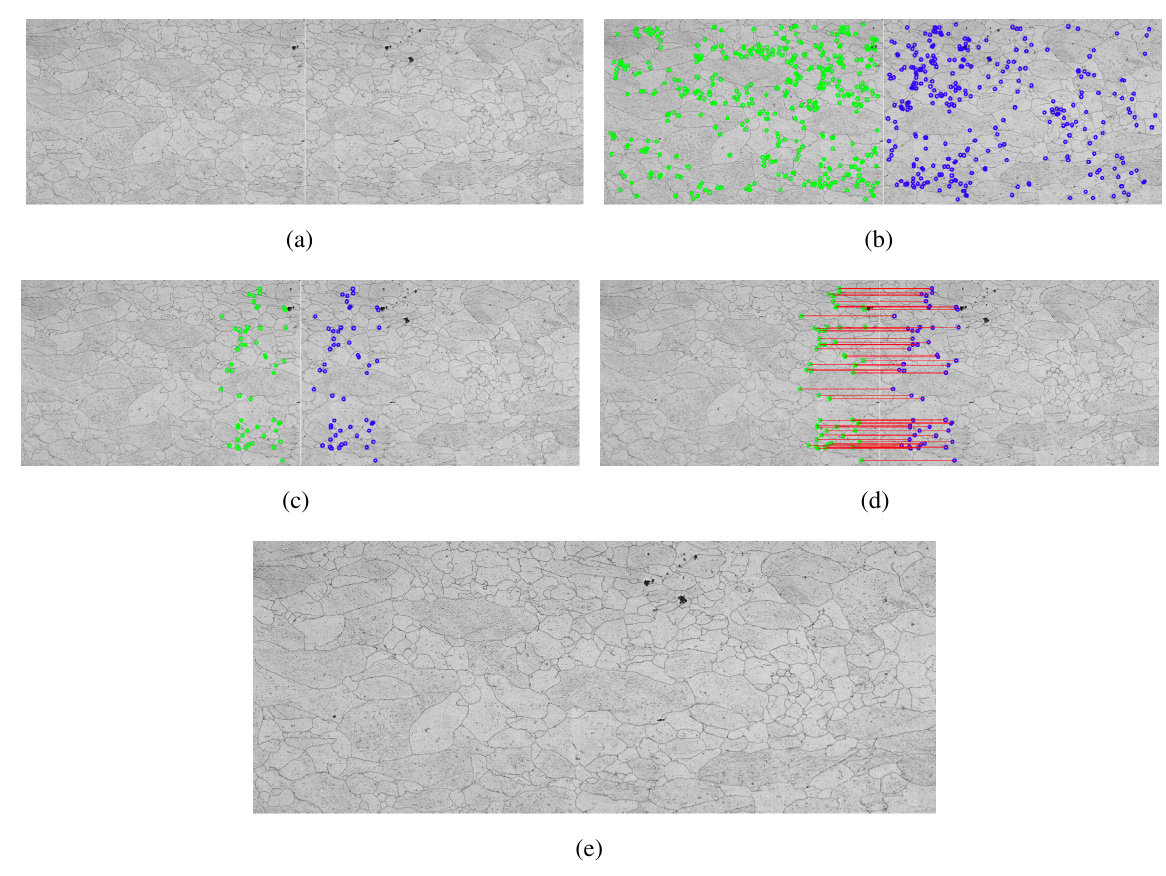
Figure 5. Example of the step by step construction using Transformed SURF, ( a ) two adjacent frames with common points; ( b ) key points located by the Transformed SURF; ( c ) choice of possible candidates for common points; ( d ) calculation of the nearest neighbor; and ( e ) the end result of grouped